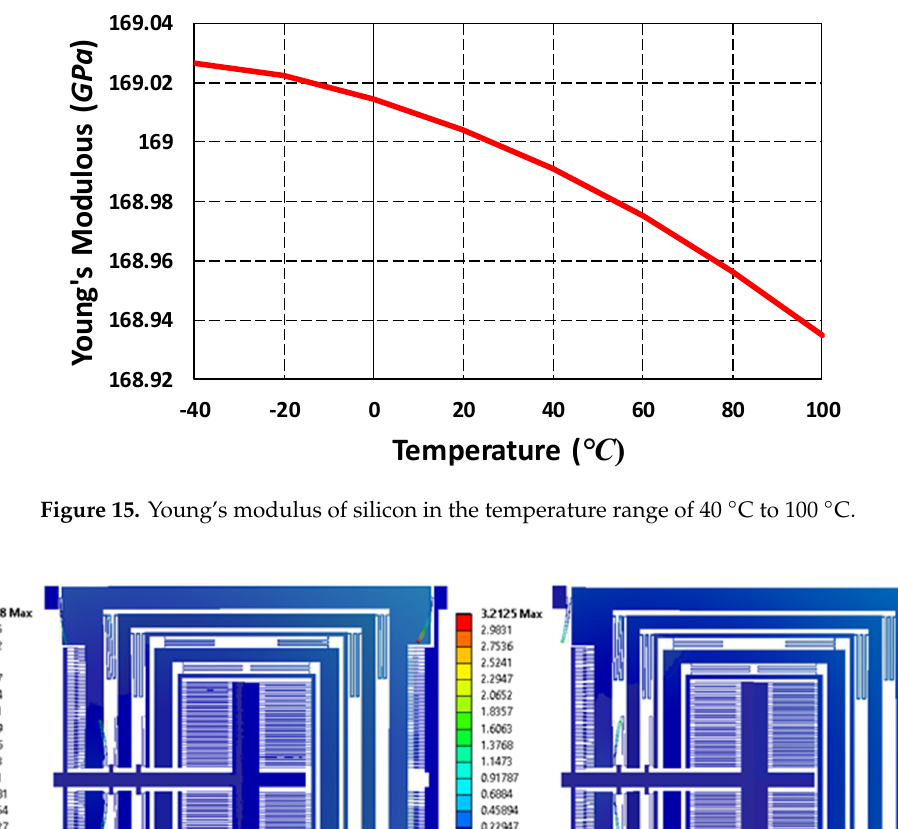
Figure 16. Structural thermal deformation in MEMS gyroscope ( a ) at 100 °C, ( b ) at − 40 °C.